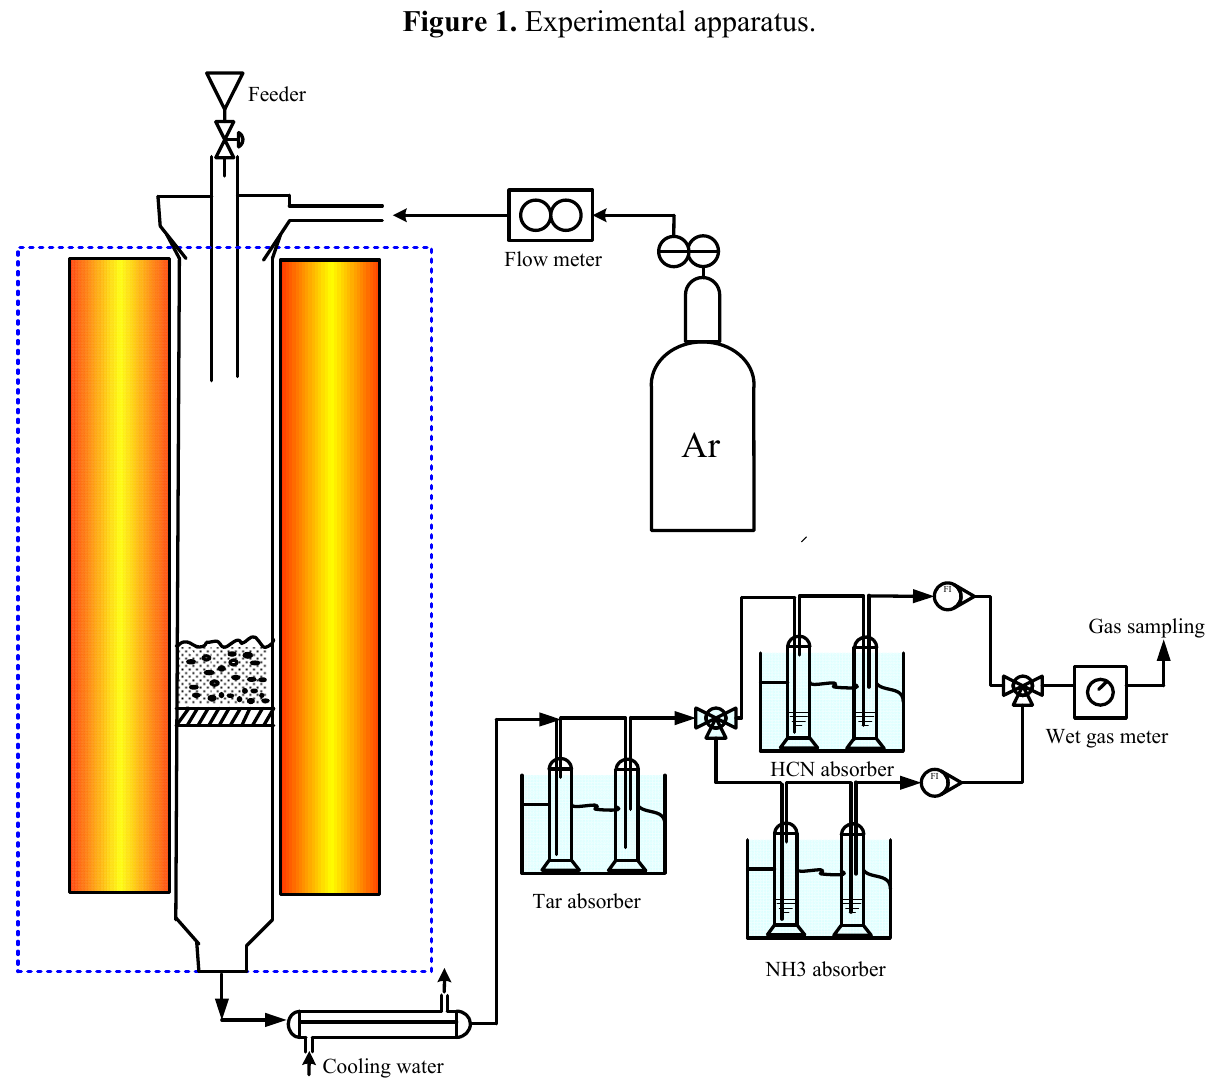
Figure 1. Experimental